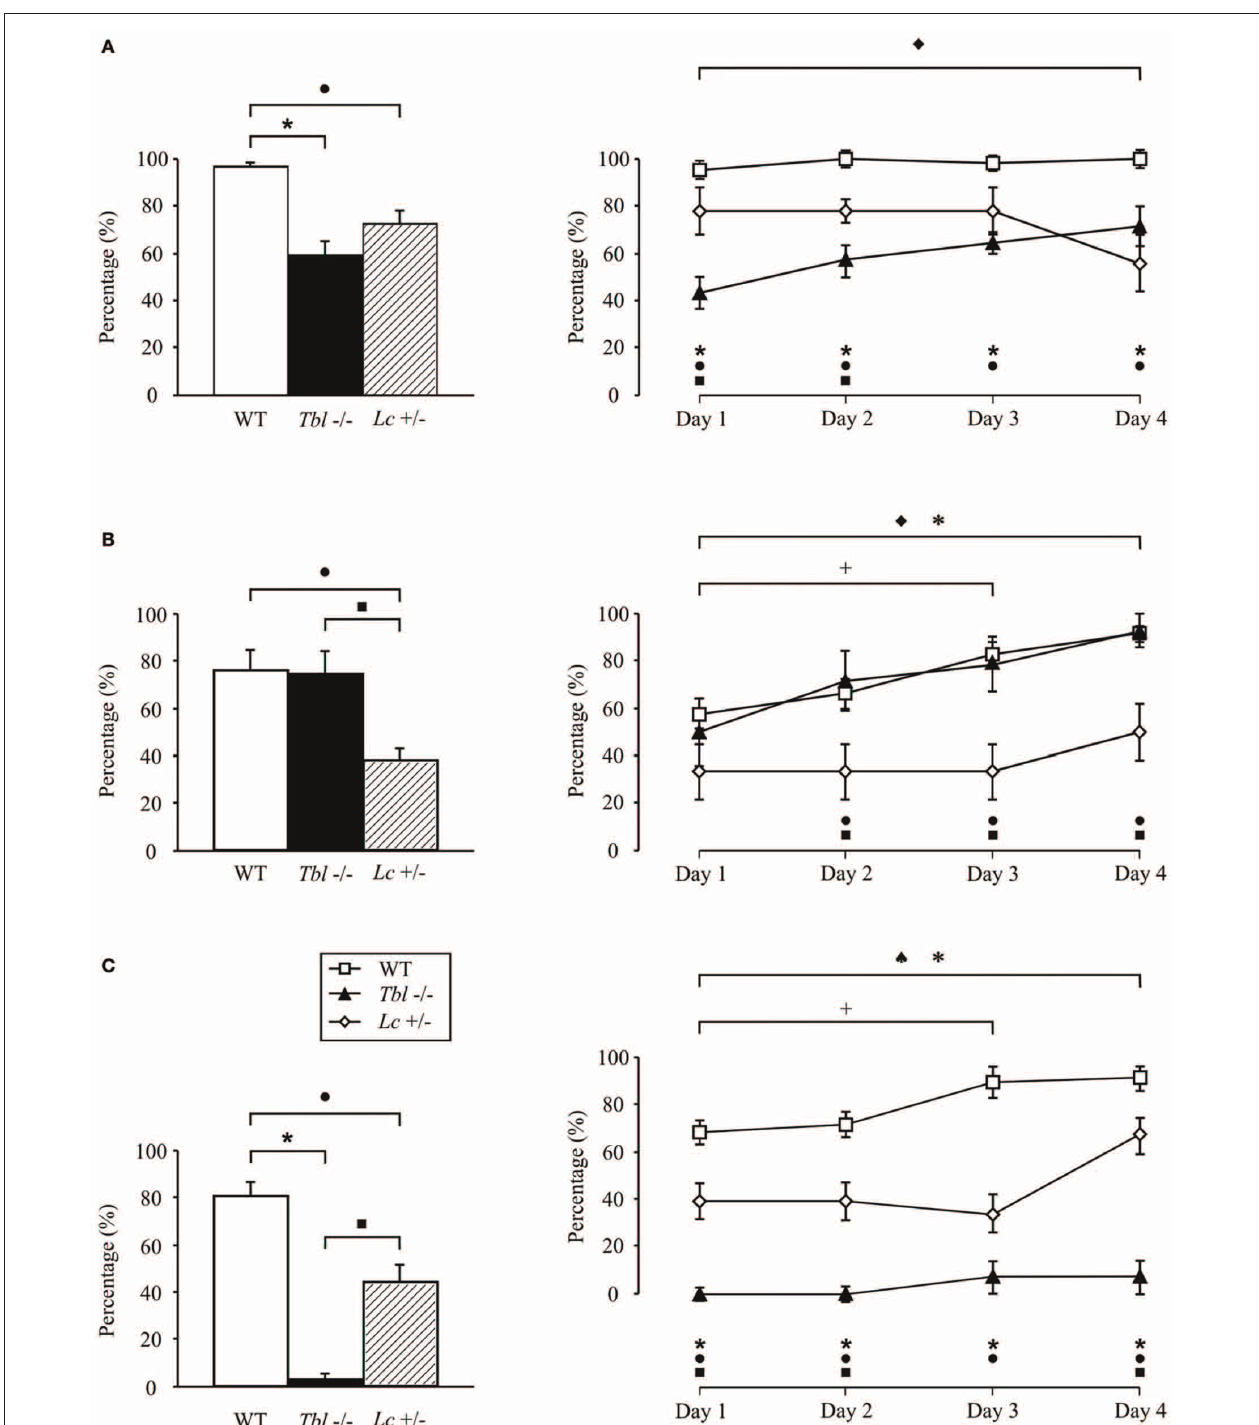
FIGURE 1 | Comparison of motor activity and motor learning in tambaleante ( tbl − / − ), Lurcher ( Lc / + ), and wild-type (WT) mice evaluated in various motor tasks: fall (A), horizontal bar (B), and vertical pole (C) performed twice a day during 4 days. Significant differences were found between groups in the percentage (%) mean values (left) [One-Way ANOVA F -test, F ( 6 , 1158 ) = 17 . 50 (fall); F ( 6 , 1158 ) = 8 . 45 (horizontal bar); F ( 6 , 1158 ) = 45 . 28 (vertical pole), P < 0 . 05] as well as in the temporal